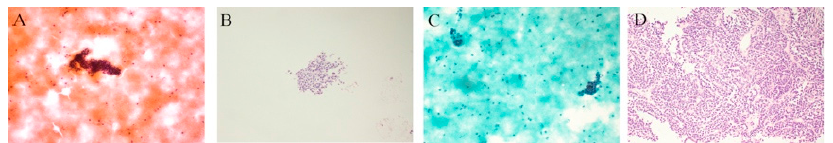
Figure 5. A cytologically-hypocellular case categorized as AUS ( A , B ) was, histologically, a basal cell adenoma. A SUMP-categorized cellular rich case was, histologically, a pleomorphic adenoma ( C , D ). Original magnification: 100 × ( A , C ), 200 × ( B , D